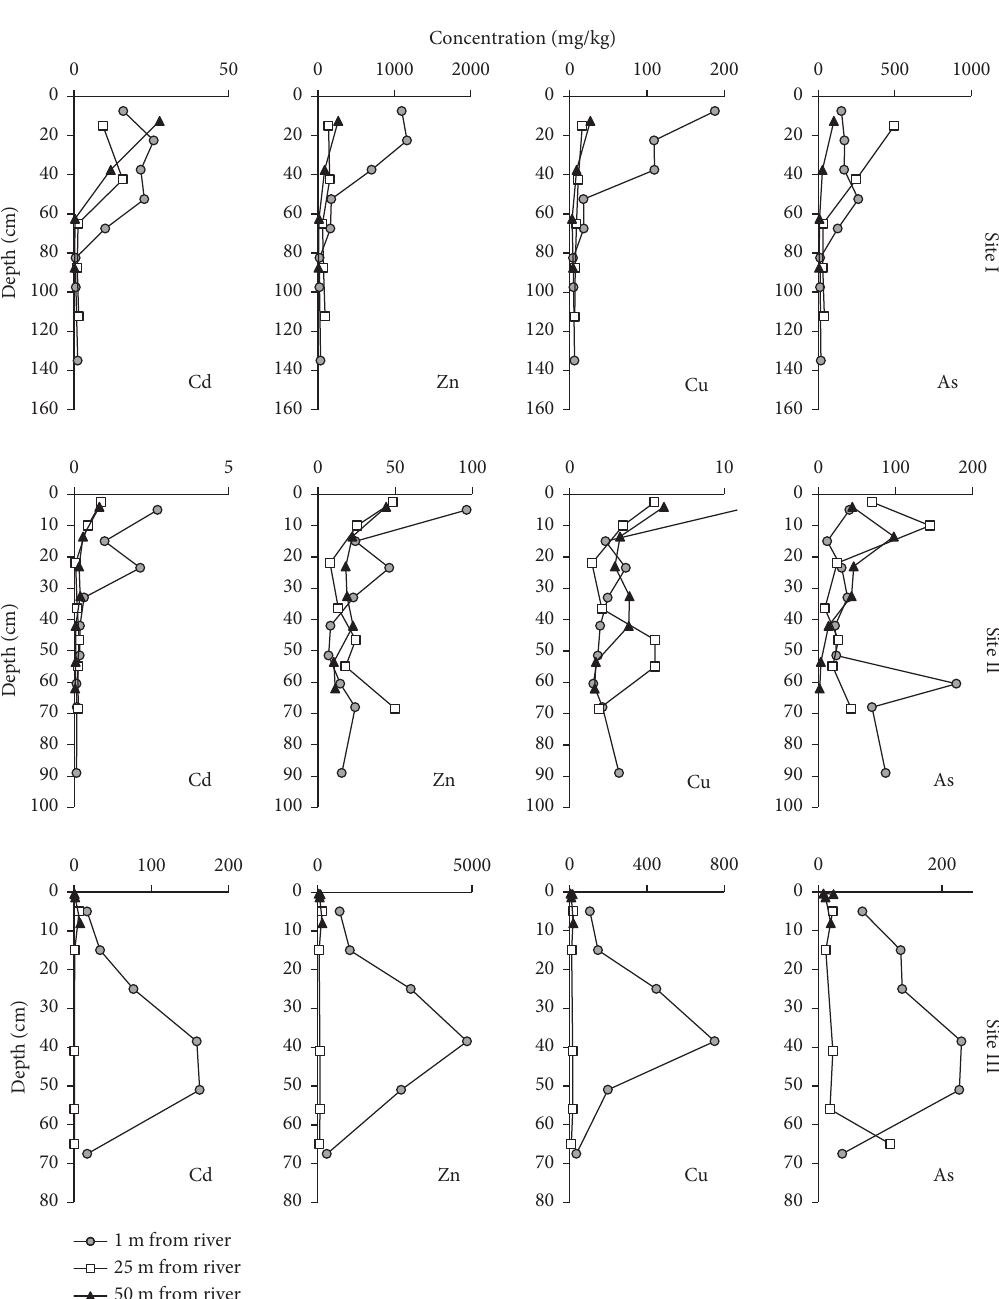
Figure 3: Vertical distribution of Cd, Zn, Cu, and As as a function of depth in profles at 1, 25, and 50m from the river (low resolution